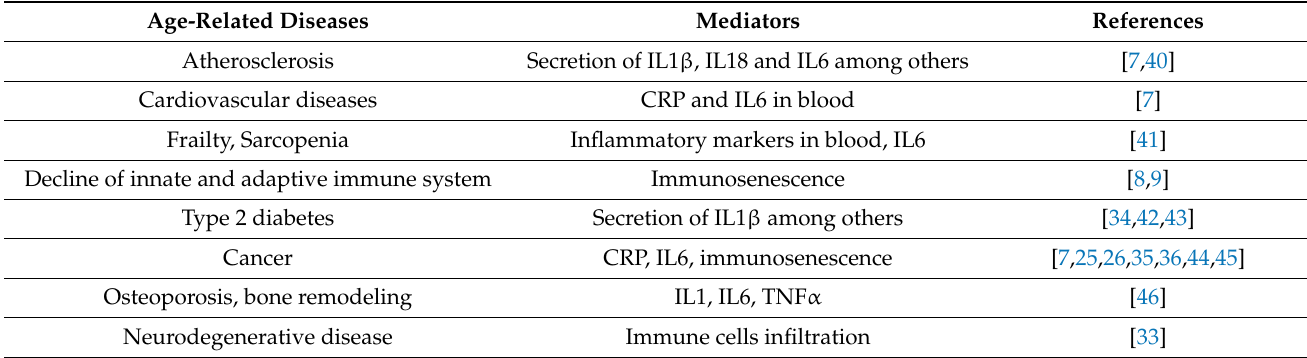
Table 1. Side effects of